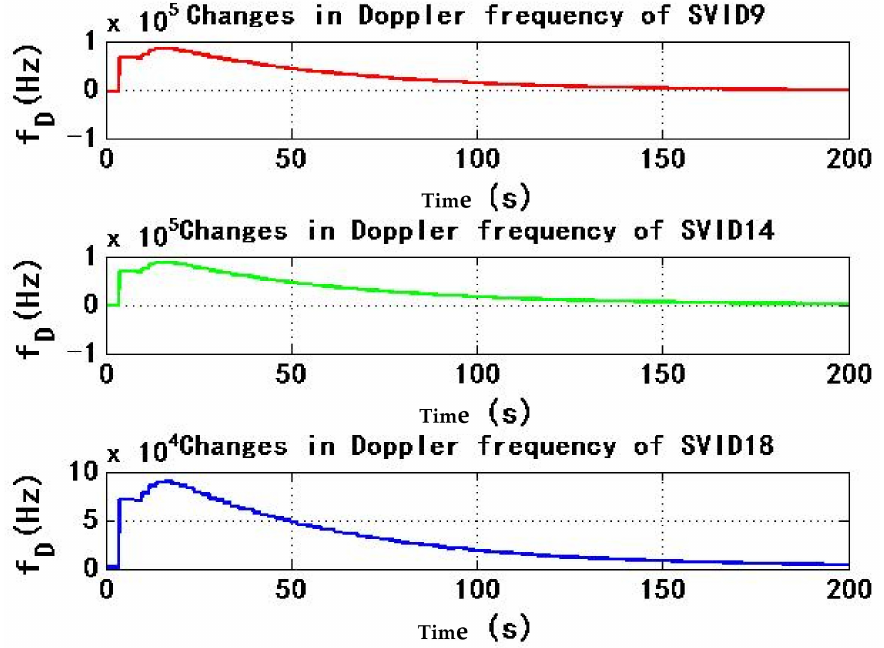
Figure 7. Changes in Doppler frequency of SVID9, 14, 18 in experiment